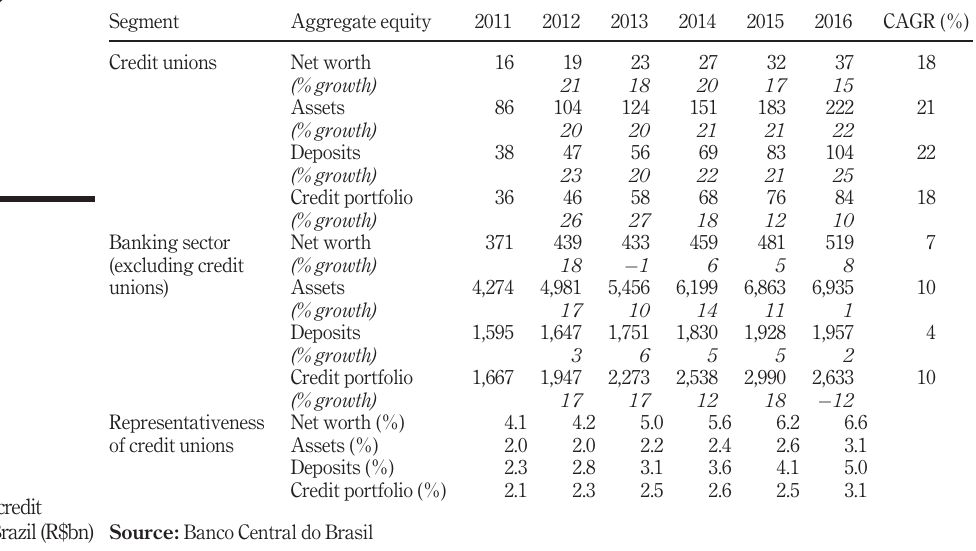
Table I. Growth of credit unions in Brazil